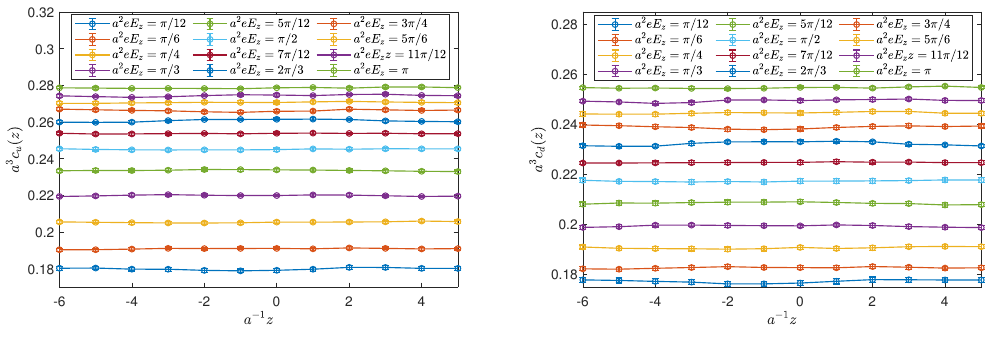
Figure 3 . c u ( z ) (the left panel) and c d ( z ) (the right panel) at β = 5 . 3